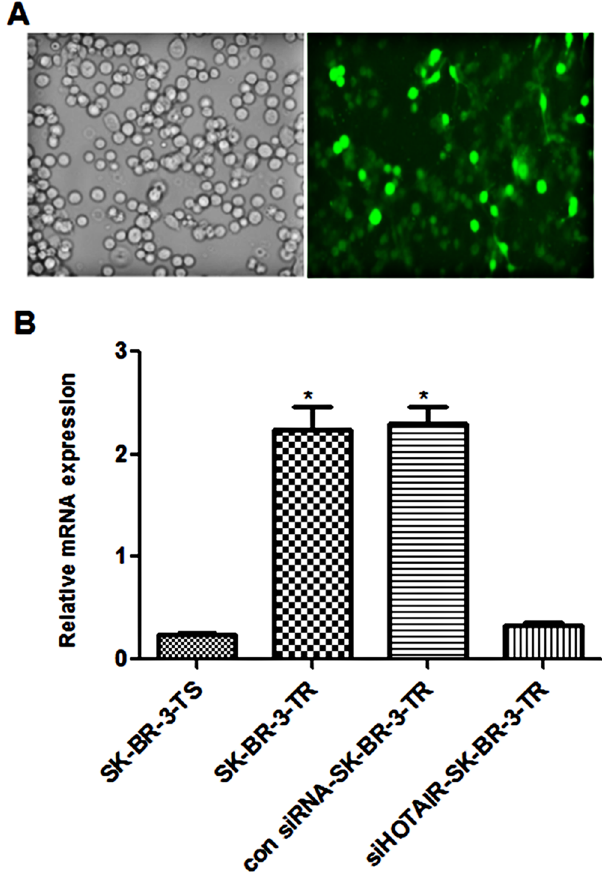
Figure 2. Expression of GFP and HOTAIR in of trastuzumab resistant cells following transfection with HOTAIR knockdown lentivirus. ( A ) Microphoto of cells under inverted phase contrast microscope and fluorescence microscope; ( B ) mRNA level of HOTAIR in trastuzumab- resistant and sensitive cells. * P < 0.05 vs